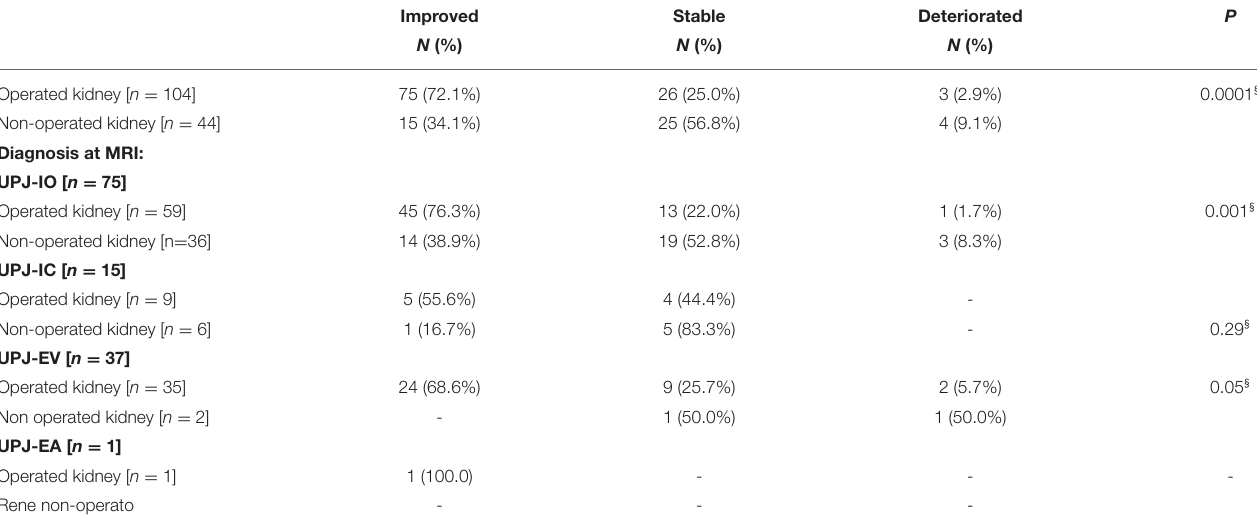
Figures in round parentheses represent row percentages. § P: Fisher’s exact